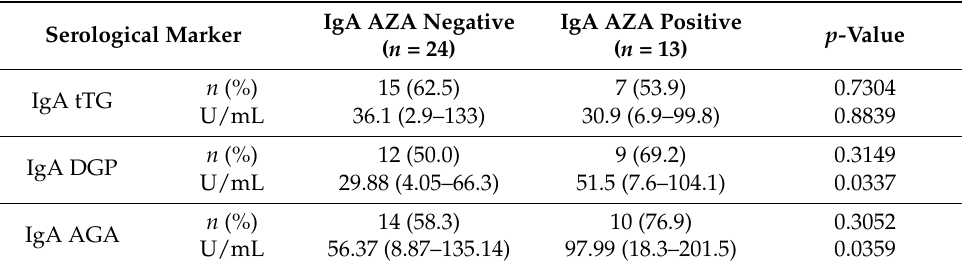
Table 3. Comparison of serological markers levels (U/mL) in patients with celiac disease in the IgA AZA-positive or -negative